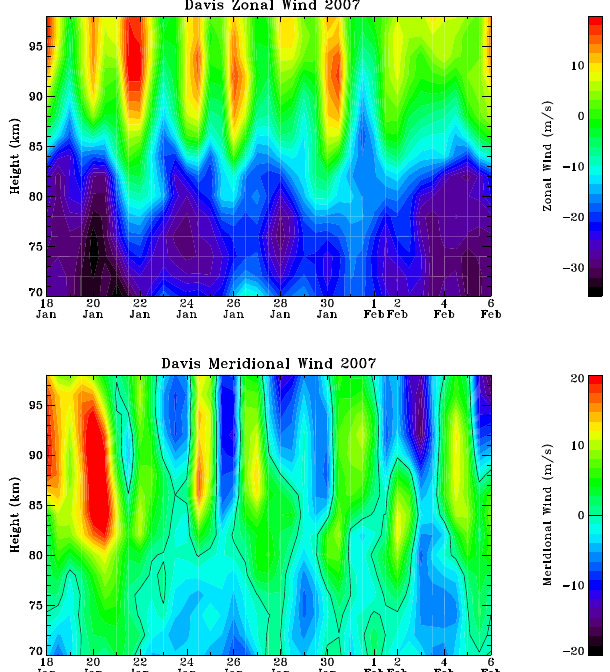
Fig. 3. Davis MF radar wind data, running average over 1 day. The top panel shows the zonal wind and the bottom panel the meridional wind [ ms − 1 ], as a function of date (x axis) and height (y axis).